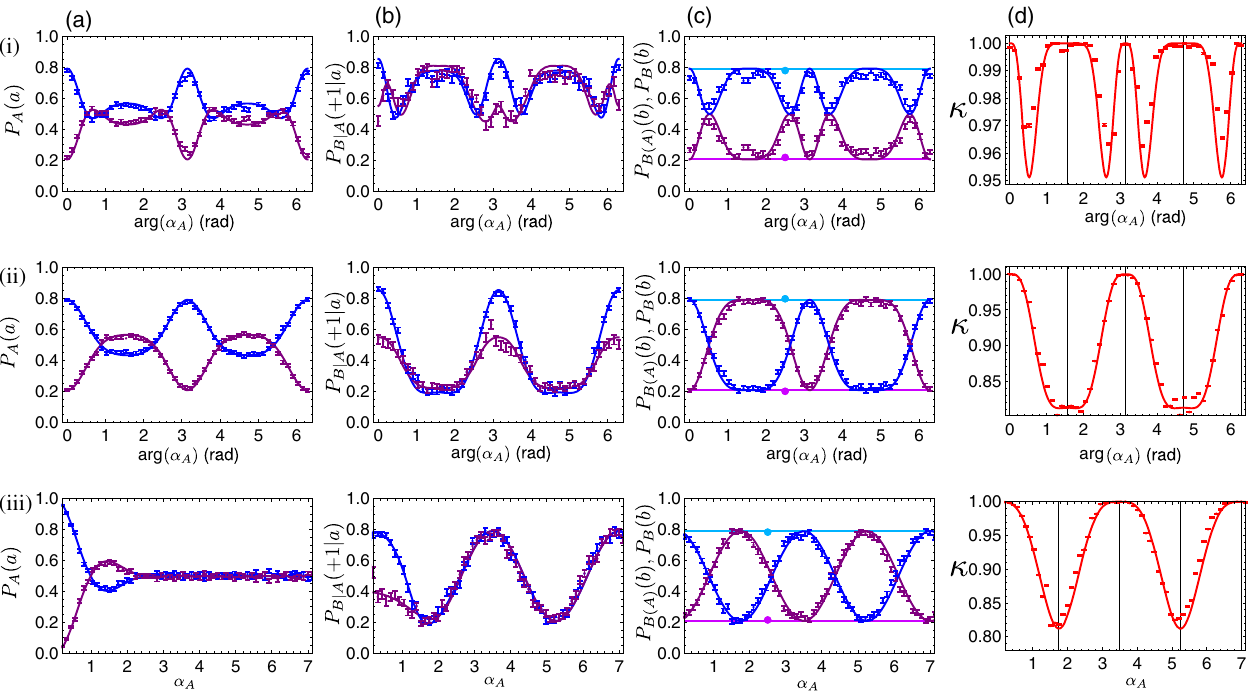
FIG. 6. Additional SIT and NSIT data compared to observable commutation. Columns (a) and (b) show the direct-detection data obtained by first measuring A and then B . The blue line corresponds to a ¼ þ 1 , while purple stands for a ¼ − 1 . Column (c) shows the result of measuring B alone. Here, P B is given as a single point plotted at arg ð α A Þ ¼ 2 . 5 , and it is compared to P B from the results of columns (a) and (b). The blue line is for b ¼ þ 1 , while purple is for b ¼ − 1 . Finally, the classical fidelity ffiffiffiffiffiffiffiffiffiffiffiffiffiffiffiffiffiffiffiffiffiffiffiffiffiffiffiffiffi q P κ ≡ P b Þ P b Þ [35] is shown in column (d). The classical fidelity can be used as an alternative to S in order to quantify the B ð B ð A Þ ð b amount of SIT. For NSIT measurements, κ ¼ 1 . The black vertical lines in column (d) indicate settings for which the underlying observables commute. (i) Asymmetric implementation, SIT as a function of arg ð α A Þ , with j α A j ¼ ϕ ϕ 0 . The data vary between SIT and NSIT, where NSIT is observed for the settings where the observables commute. (ii) The A ¼ B ¼ same experiment with the symmetric implementation, ϕ A ¼ ϕ B ¼ π . We observe that this implementation can be SIT even in cases where the observables commute. (iii) SIT as a function of α A in the symmetric implementation with α B ¼ α I ≈ observed at points where the observables